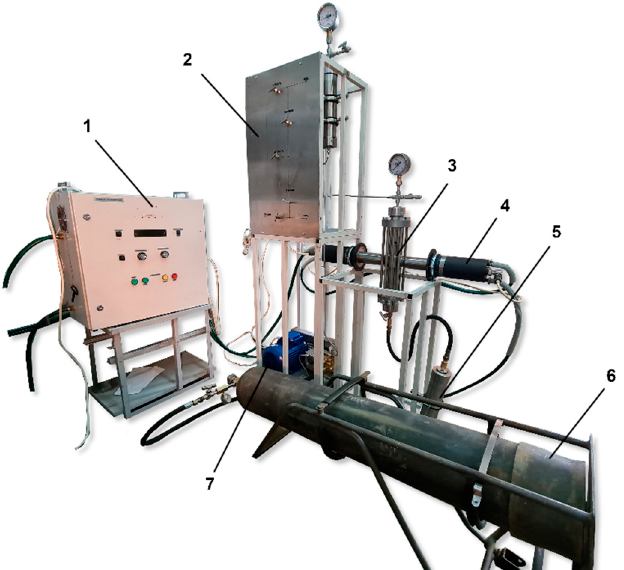
Figure 2. Experimental setup. 1: generator; 2: control panel; 3: reactor; 4: transducer; 5: pressure relief tank; 6: food-grade carbon dioxide cylinder; 7: pump.